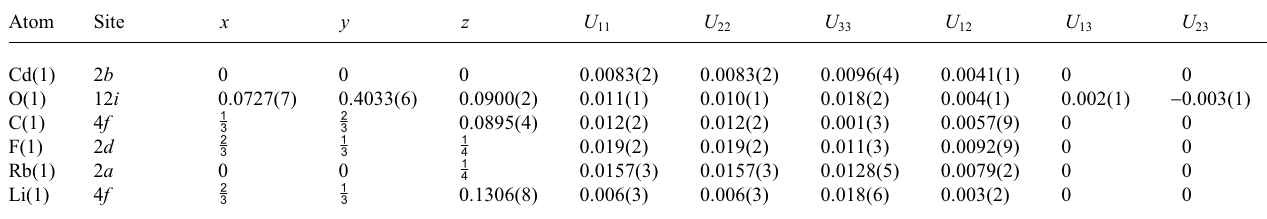
Table 2. Atomic coordinates and displacement parameters (in Å 2 ) .